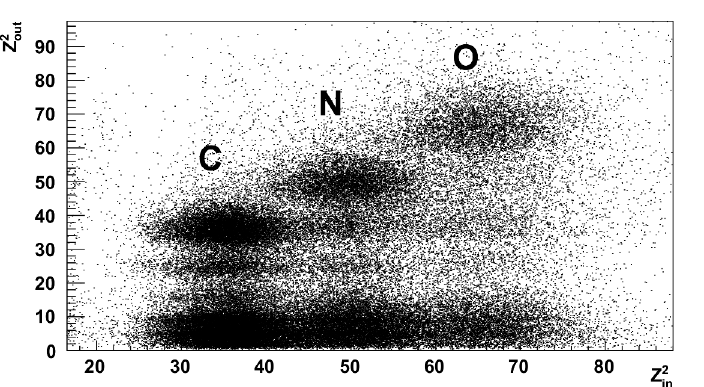
Figure 4. The dependence of the square of the particles charge after the beam-target interaction on the one before the